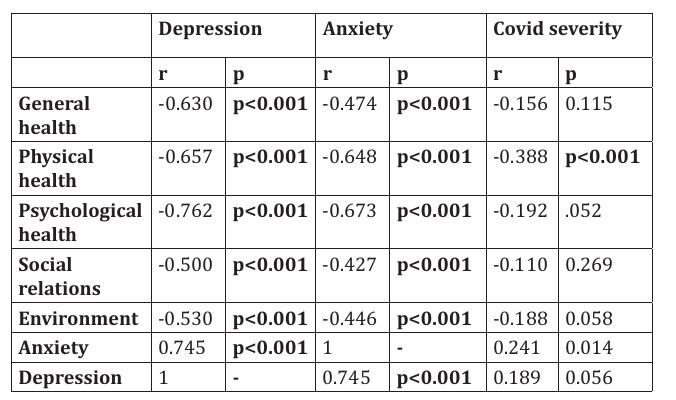
Correlations between various parameters and Quality of Life and Hospital Anxiety and Depression Scale